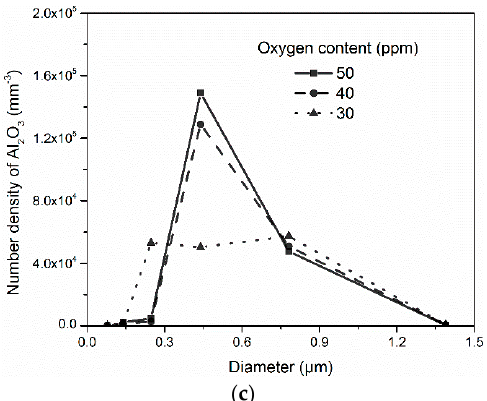
Figure 9. Influence of oxygen content on the size distribution of ( a ) ASlag, ( b ) Ti 3 O 5 and ( c ) Al 2 O 3 at solidus temperature.